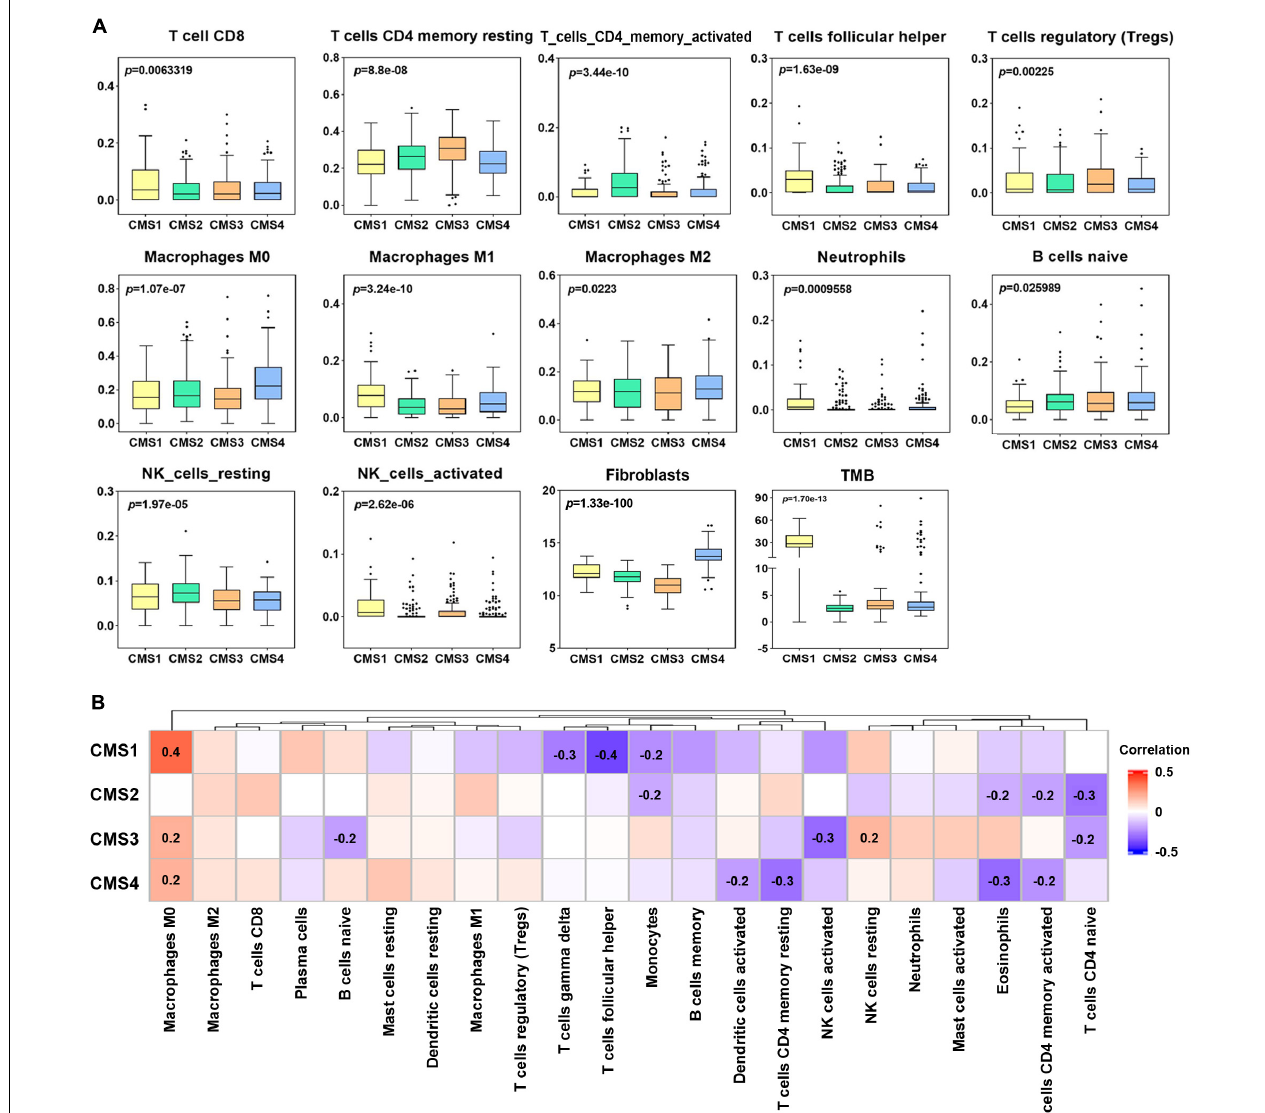
FIGURE 6 | Levels of immune cell infiltration in different colon cancer subtypes. (A) Differential analysis of the immune cell infiltration level, fibroblasts and tumor mutation burden (TMB) in different colon cancer subtypes ( p < 0.05). (B) Correlation analysis between fibroblasts and the levels of twenty-two infiltrating immune cell types in the different colon cancer subtypes. Red indicates a positive correlation, and blue indicates a negative correlation. The numerical value represents the degree of correlation ( p <